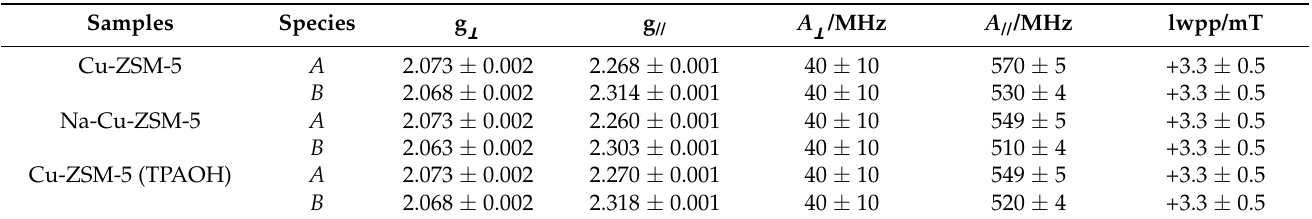
Figure 9. Experimental (black) and simulated (red) spectra of the dehydrated Cu-exchanged ZSM-5. The low field part of the experimental and simulated spectrum is reported on the bottom left of each spectrum. The simulation is obtained by summing the spectra of two different Cu species ( A in blue and B in green) with a proper weight. Table 5. Spin Hamiltonian parameters and broadening values (lwpp) used for the simulations of Cu species in the activated (dehydrated) Cu-exchanged ZSM-5.